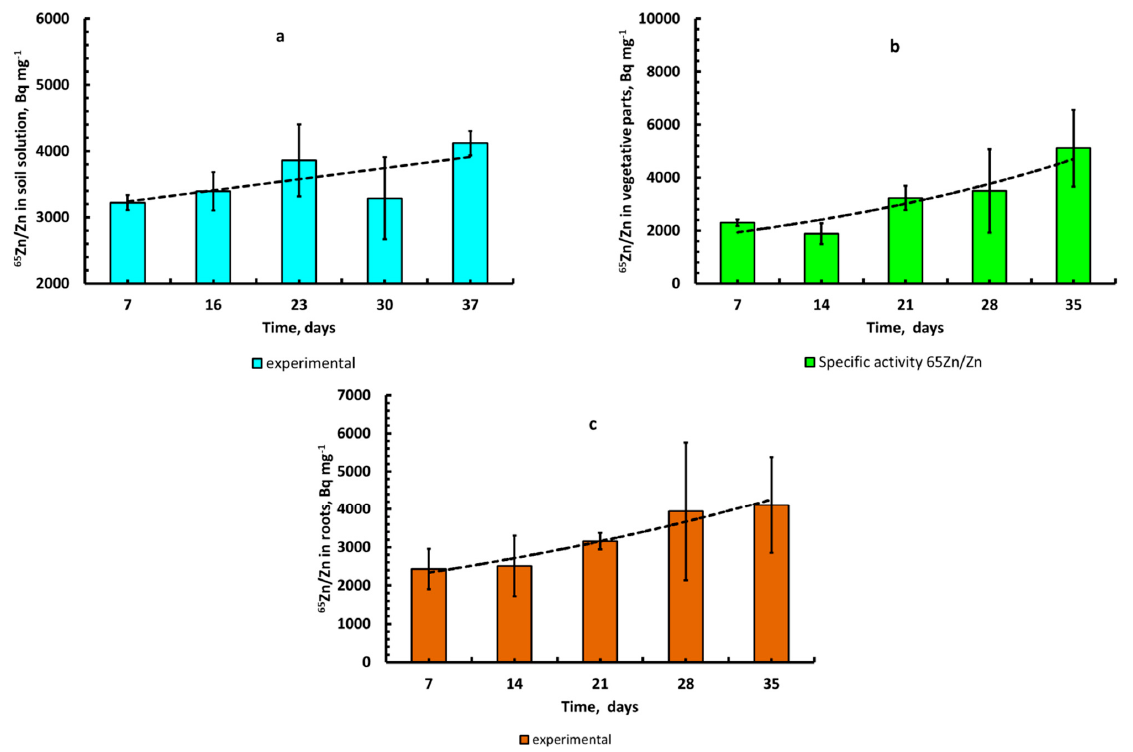
Figure 8. Experimental data for the specific activity: A sp ( 65 Zn/Zn) soil solution ( a ), A sp ( 65 Zn/Zn) VPs ( b ), and A sp ( 65 Zn/Zn) roots ( c ), Bq×mg − 1 (mean value ± standard deviation; n = 3).